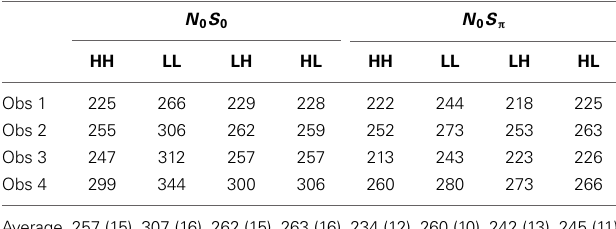
Table 3 | Mean reaction times in ms for the dual-target conditions.